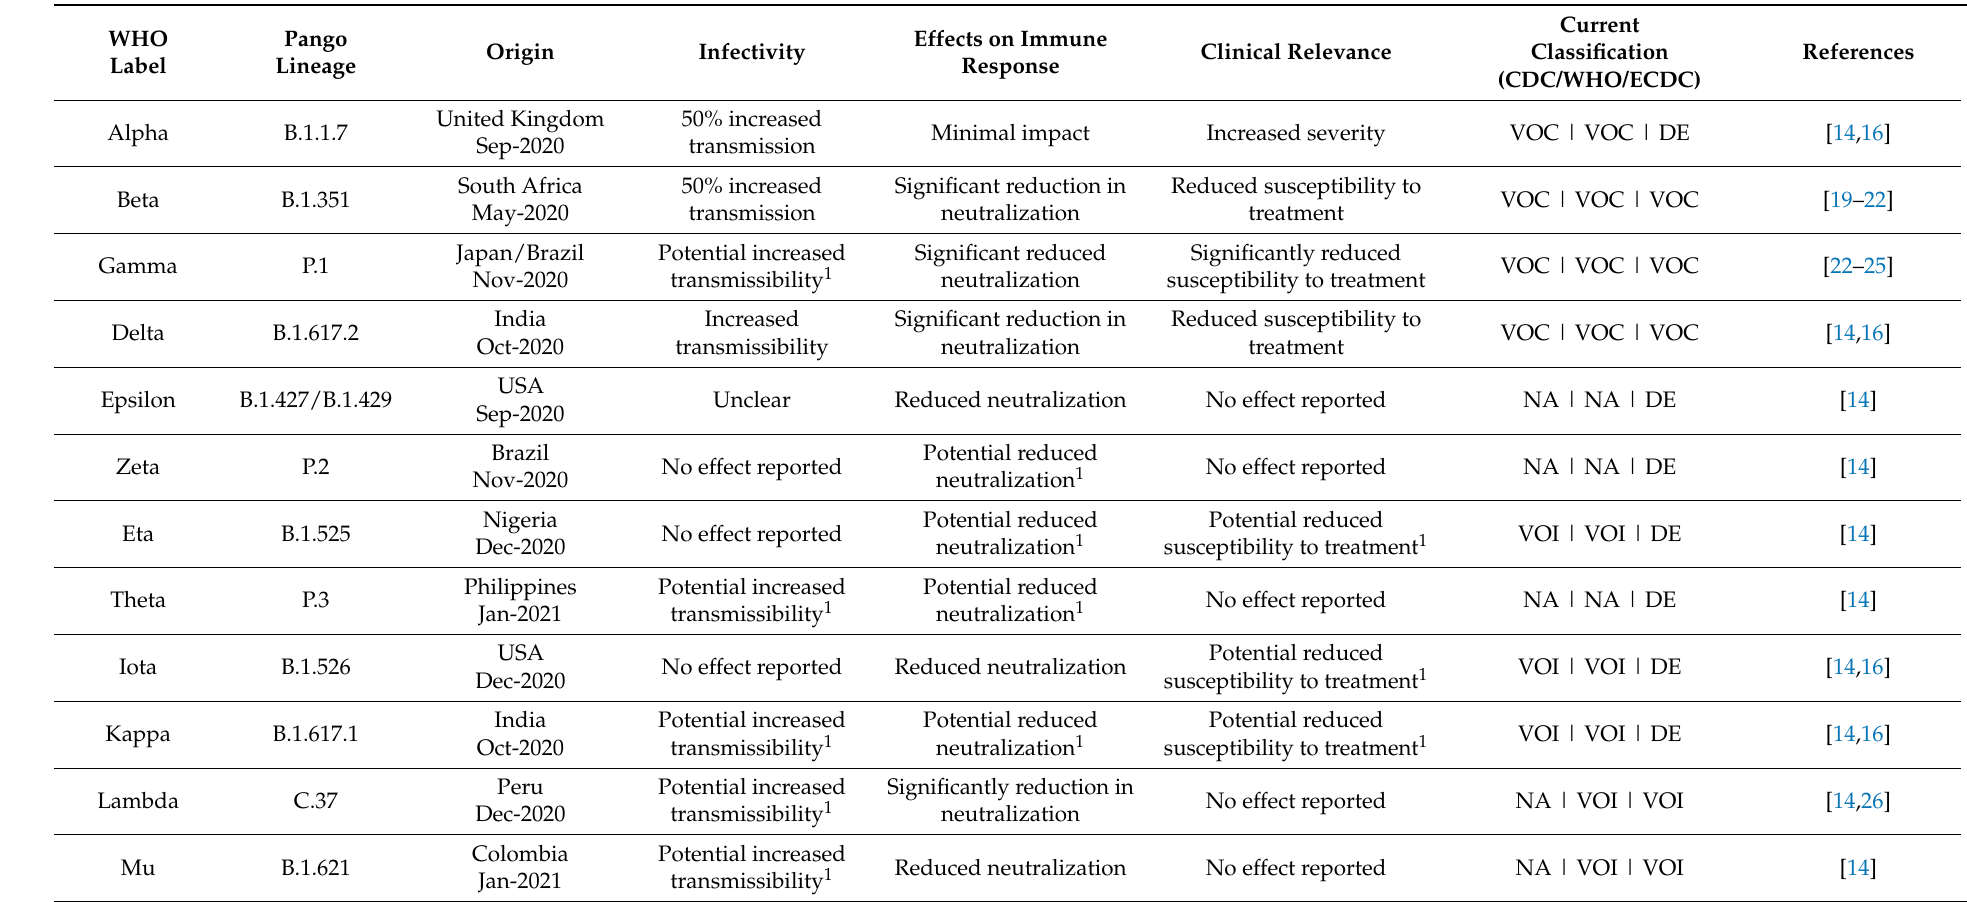
Table 1. List of variants currently or in the past considered as variants of concern or variants of